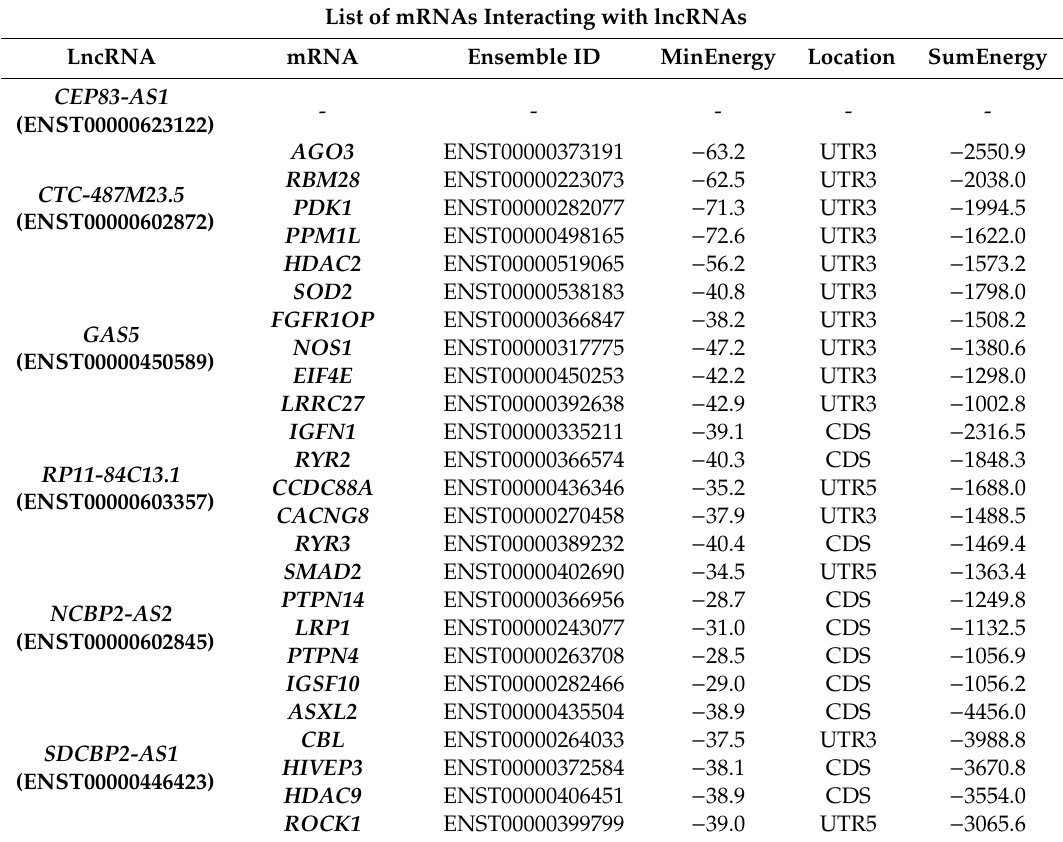
Table 3. List of interaction between lncRNAs and putative mRNAs. List of mRNAs Interacting with